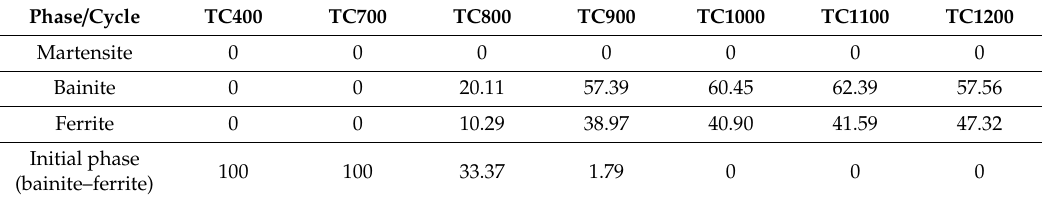
150 Figure 12. Comparison of the real and calculated results of measurements of hardness in thermo- mechanically and numerically simulated HAZ areas of S700MC steel. Based on the metallurgical phase distributions and the calculated cooling times t 8/5 , VisualWeld (SYSWELD) also allows you to calculate the hardness distribution. The results of selected analyses are presented and compared with the results of real measurements in Figures 12 and 13. 0 50 100